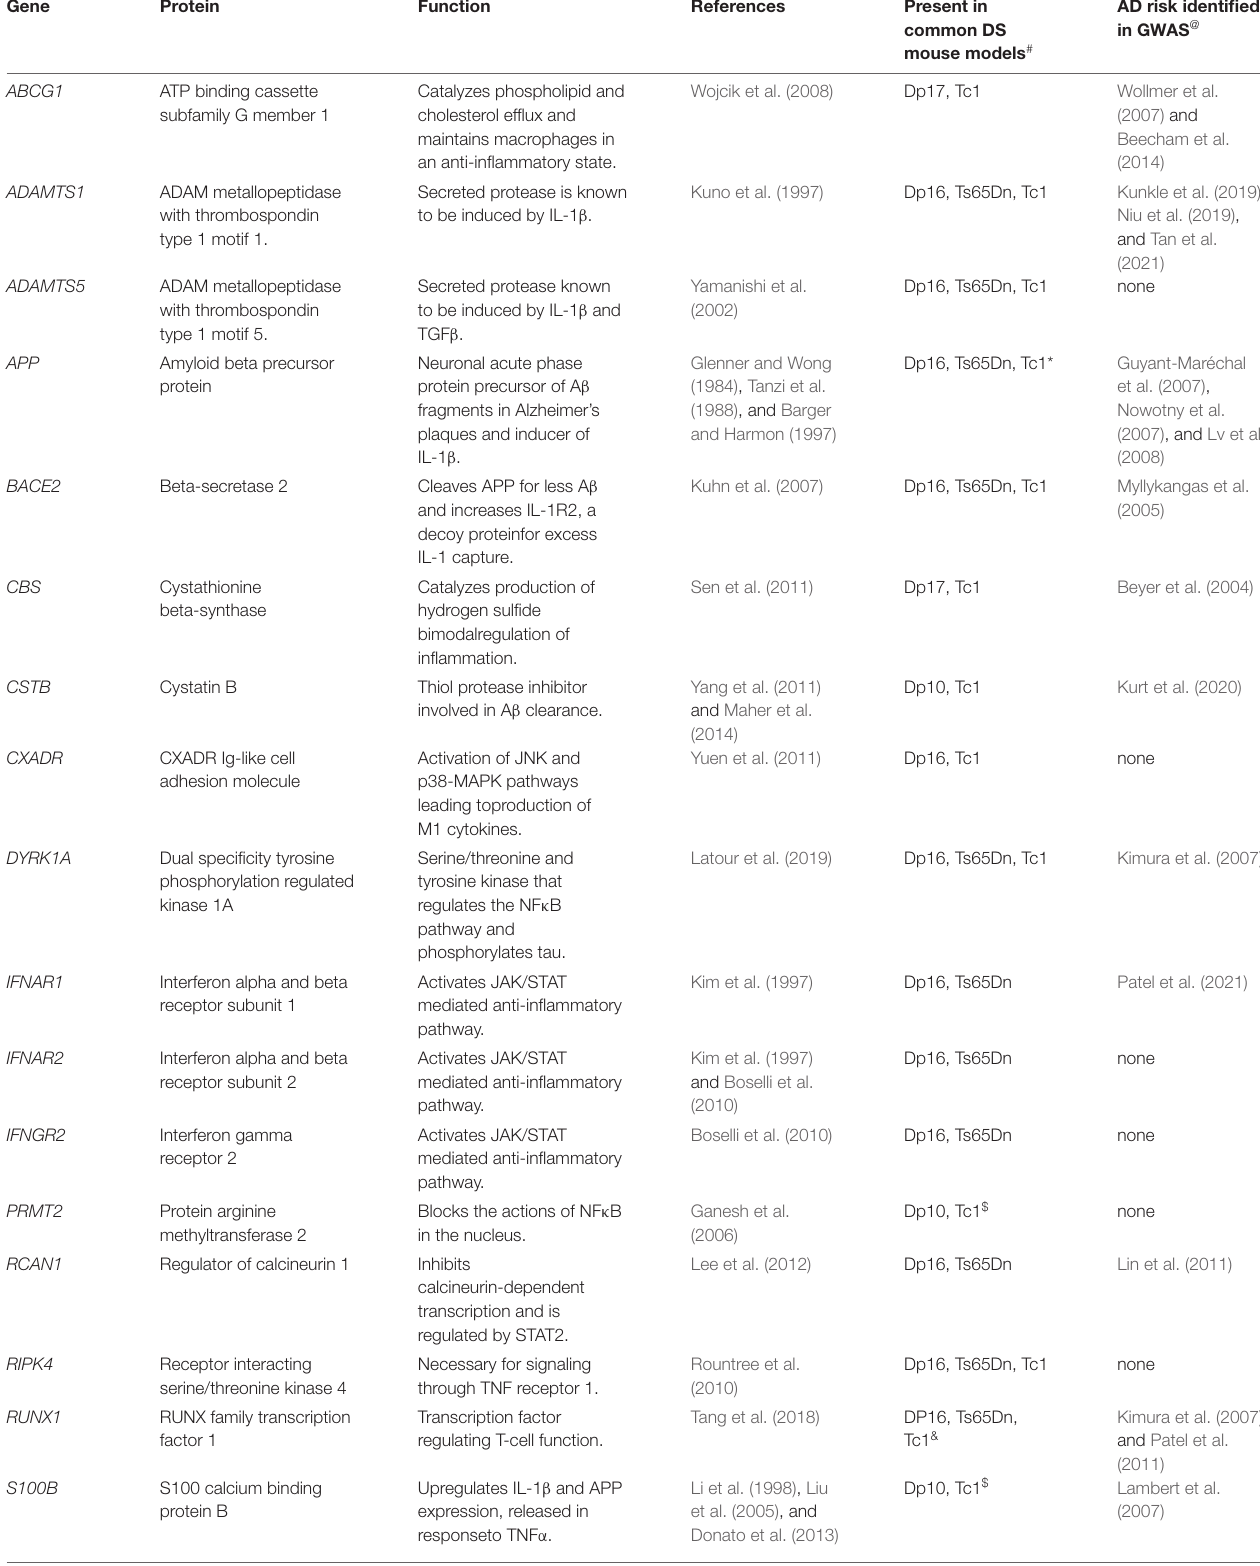
TABLE 1 | A summary of inflammation-related genes located on